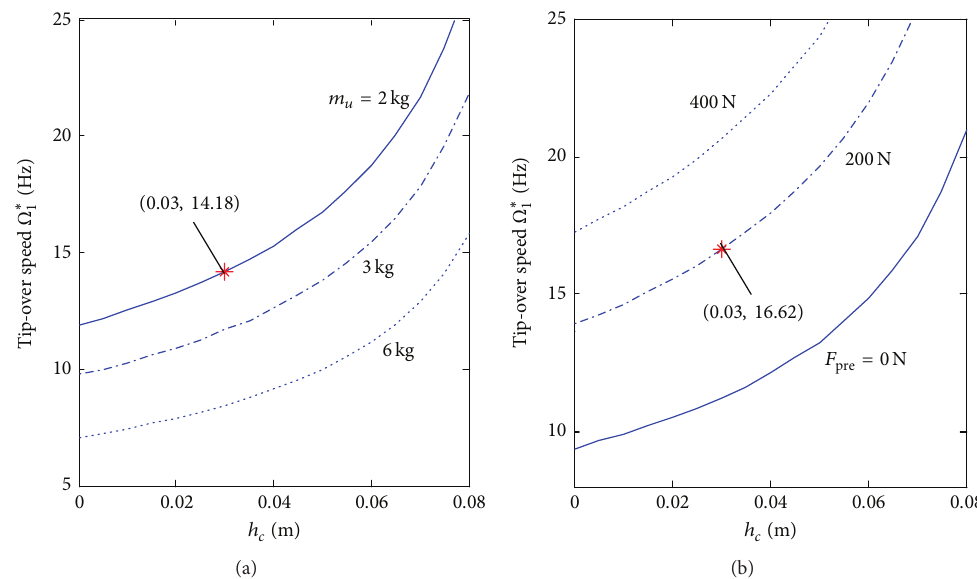
Figure 4: Variations of the tip-over speed Ω ∗ 1 along with increases of 𝑚 𝑢 and ℎ 𝑐 when pretightening force 𝐹 pre = 100 N (a). Changes of the tip-over speed Ω ∗ 1 along with variations of 𝐹 pre and ℎ 𝑐 when 𝑚 𝑢 = 2 kg (b).